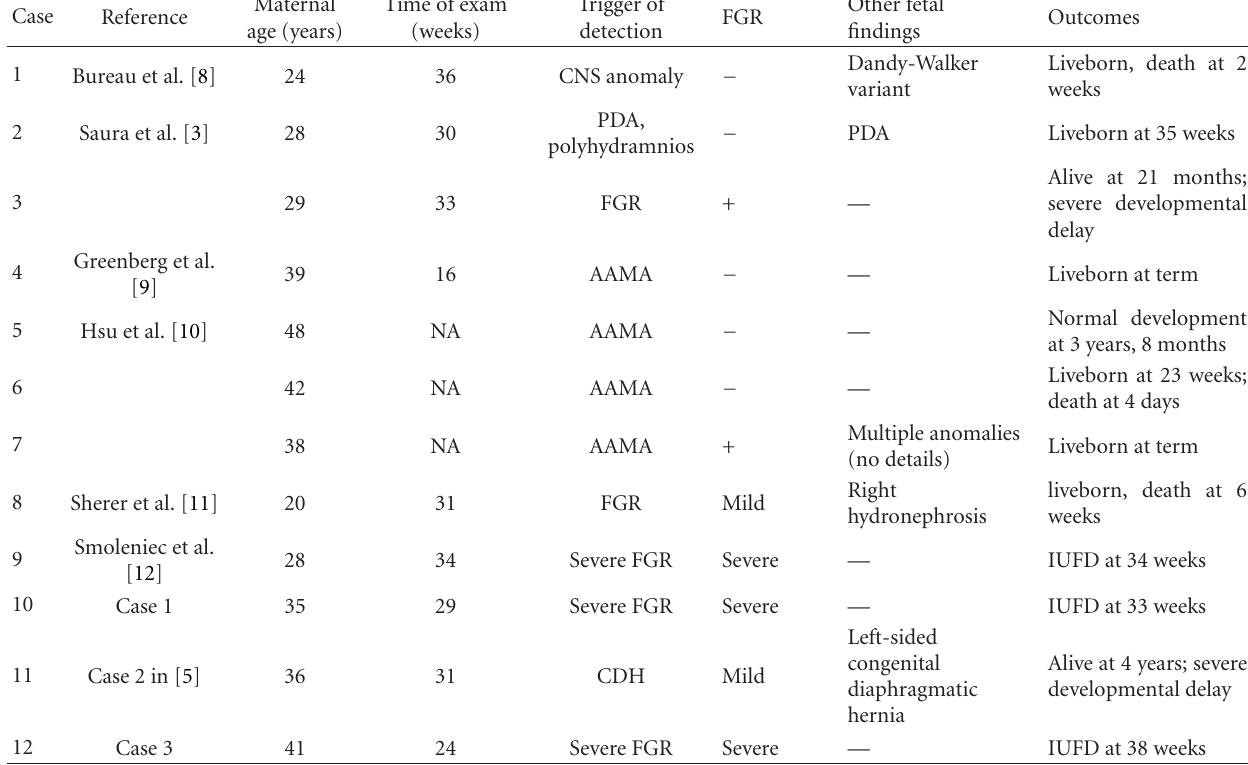
Table 2: Characteristics and outcomes of reported cases of prenatal trisomy 9